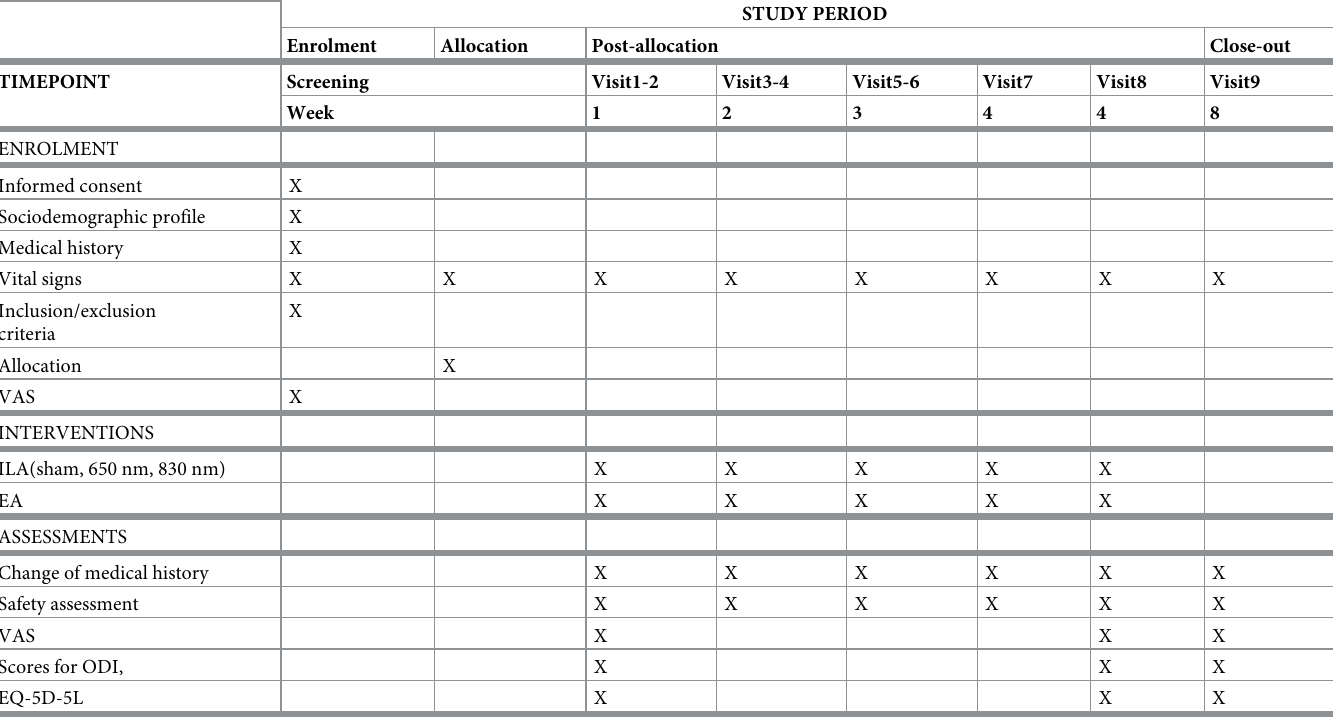
Table 1. Standard Protocol Items: Recommendations for Interventional Trials (SPIRIT)